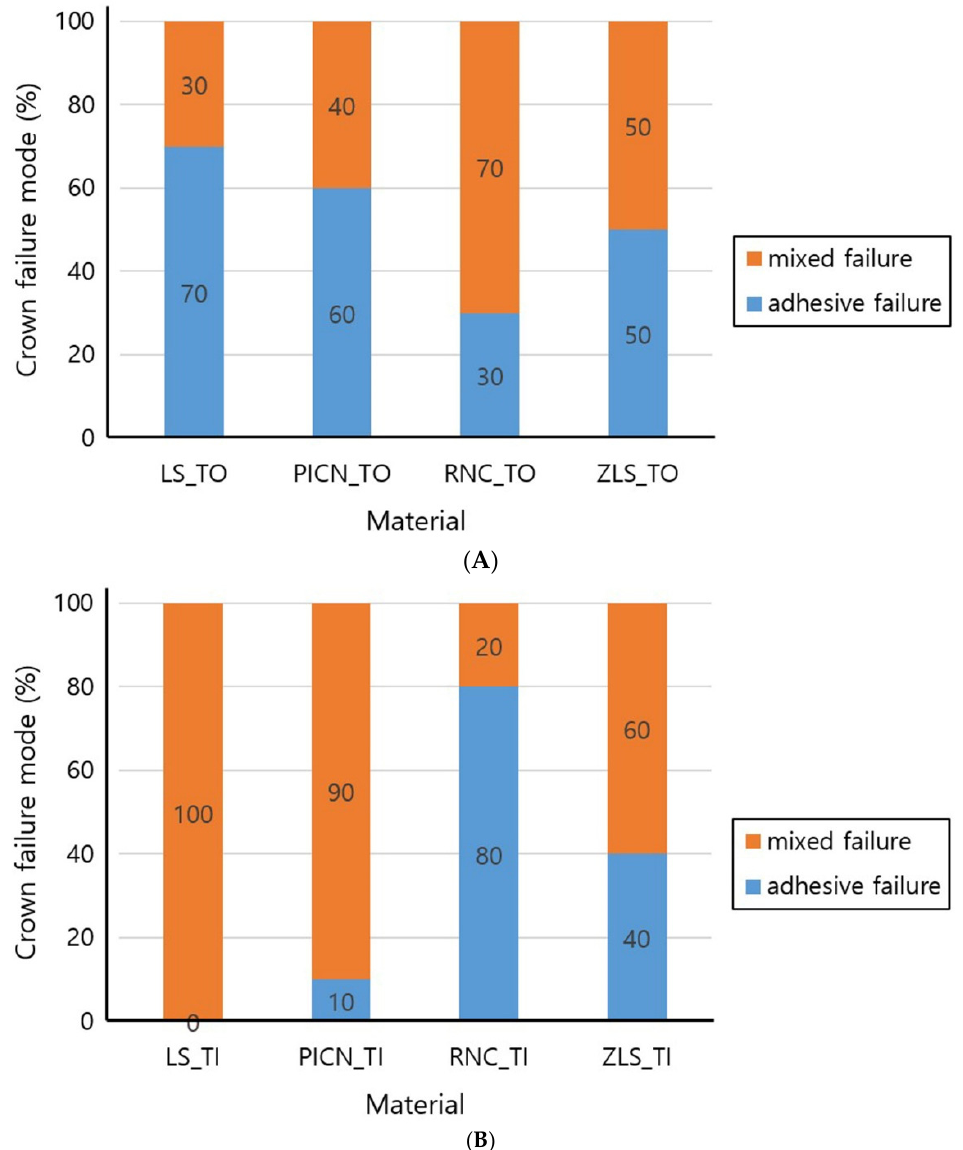
Figure 4. Crown failure mode ( A ): Tooth abutment. ( B ): Titanium abutment. LS, lithium disilicate; PICN, polymer-infiltrated-ceramic-network; RNC, resin nano ceramic; ZLS, zirconia-reinforced lithium silicate; TO, tooth abutment; TI, titanium abutment.